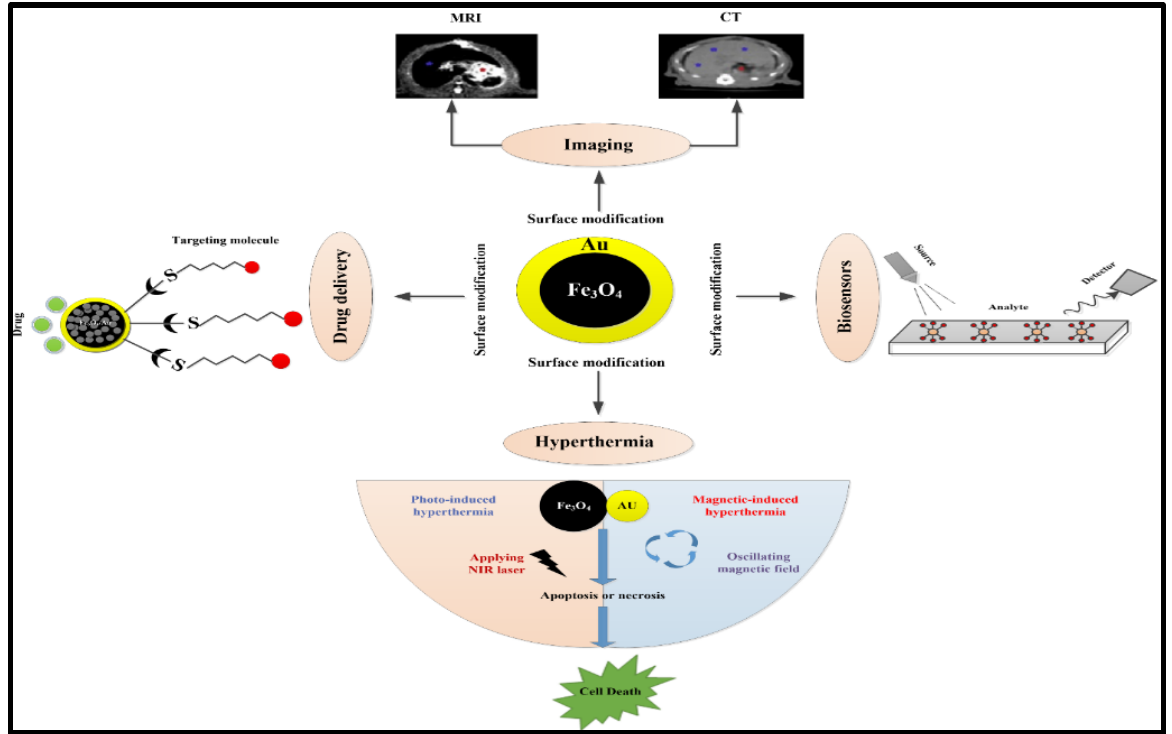
Figure 5. Schematic representation of the medical applications of Fe 3 O 4 @Au NPs